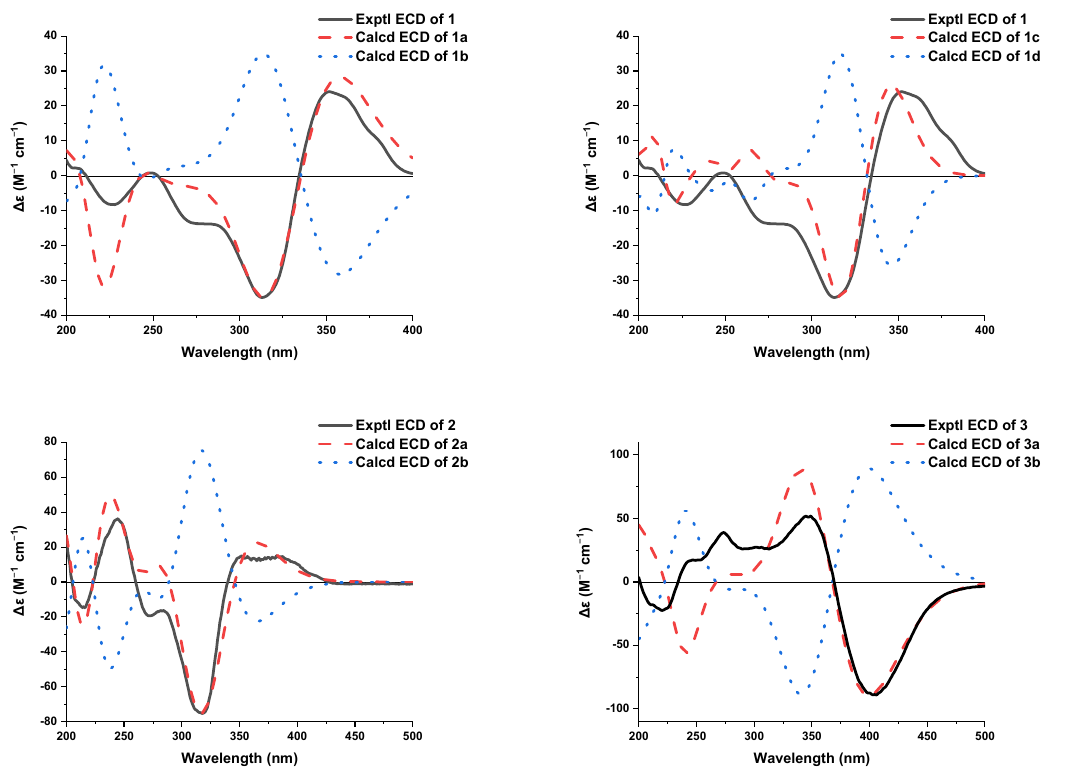
Figure 4. Calculated and experimental ECD spectra of compounds 1 – 3 . Acresorbicillinol B ( 2 ) was obtained as a pale yellow solid. The molecular formula of 2 was assigned as C 22 H 24 O 5 (11 degrees of unsaturation) based on its HRESIMS data at m/z 369.1696 [M + H] + (calcd for C 22 H 25 O 5 , 369.1697). The 1 H and 13 C NMR spectroscopic data 22 carbon resonances including 3 methyl groups, 1 sp 3 methylenes, 2 sp 3 methines, 2 sp 3 non-protonated carbons with 1 oxygenated, 12 olefinic or aromatic carbons (8 protonated), and 2 carbonyl carbons ( δ C 211.4, and 199.7, respectively), which were similar to those of 1